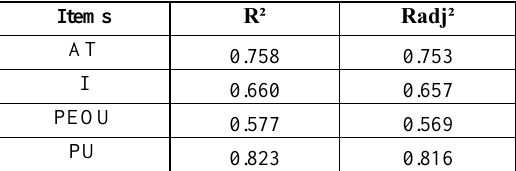
Table 3: Hypotheses Results